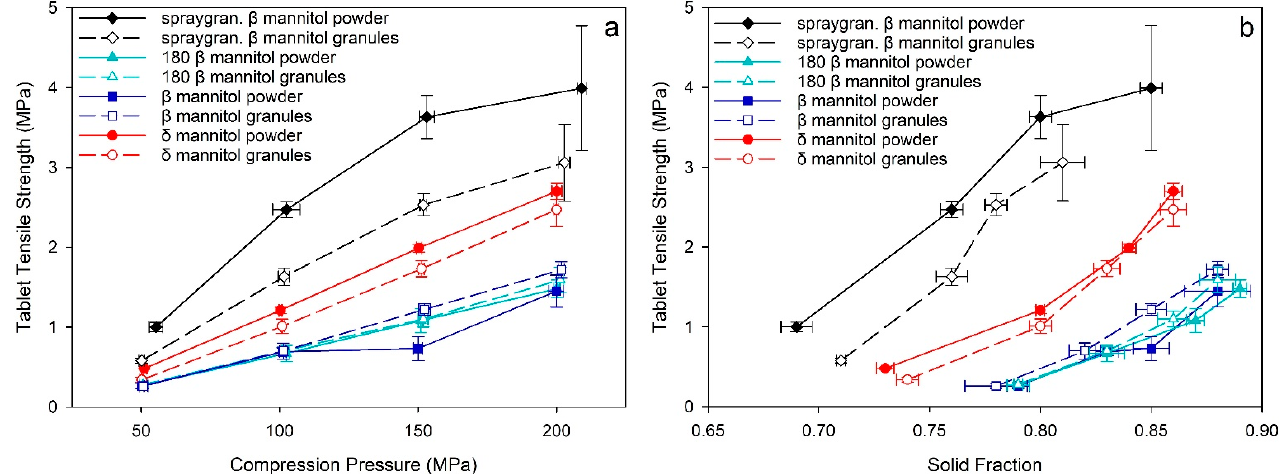
Figure 7. ( a ) Tabletability and ( b ) compactability plot of δ and β mannitol, β mannitol sieved through 180 µm sieve, and spray granulated β mannitol and their respective roller compacted granules. Arithmetic means of n = 10 ± S.D.